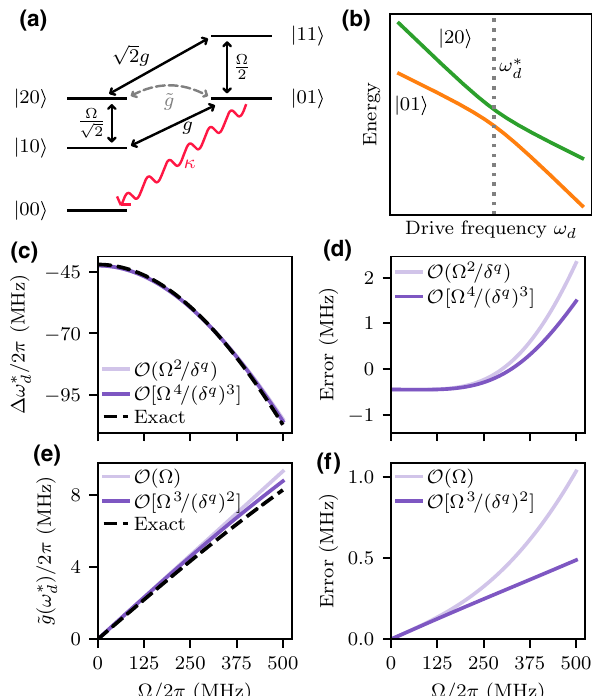
FIG. 1. Concept of the readout-resonator LRU. (a) The state | 20 (cid:2) (with the notation | transmon,resonator (cid:2) ) is connected to | 01 (cid:2) by two main paths via either | 11 (cid:2) or | 10 (cid:2) , due to the capacitive coupling g or the transmon-drive amplitude (cid:6) , respec- tively. This generates an effective coupling ˜ g that can be used to swap | 20 (cid:2) ↔ | 01 (cid:2) . The latter quickly decays to | 00 (cid:2) due to the typically high coupling κ of the readout resonator to the transmission-line environment, overall removing leakage from a leaked transmon. (b) In the rotating frame of the drive, | 20 (cid:2) and | 01 (cid:2) show an avoided crossing as a function of the drive ) is . The effective coupling ˜ g (ω ∗ frequency ω d , centered at ω ∗ d d equal to half the energy separation at that point. (c),(e) The − ( 2 ω + α − ω ) and ˜ g (ω ∗ ) are respectively : = ω ∗ values (cid:8)ω ∗ q r d d d evaluated either exactly by full numerical diagonalization of H in Eq. (1), or by approximate analytical formulas (see Sec. I A and Appendix A) for the parameters in Table I. The absolute errors with respect to the exact curves are shown in (d) and (f),